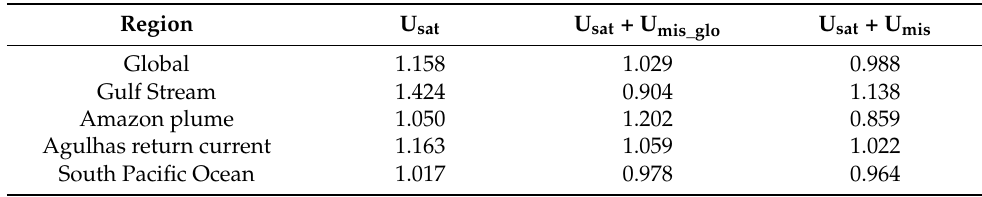
Figure 4. Distribution of differences between Argo floats and CCI data normalized with U sat (orange), with U sat and U mis_glo (red) and with U sat and U mis (blue), and corresponding Gaussian fits, over the global ocean. The black line corresponds to a theoretical Gaussian distribution with a standard deviation of 1. Corresponding STD are reported in Table 2. Table 2. STD of the distributions of the normalized differences between Argo and CCI v3.2 weekly products, in the regions defined in Table